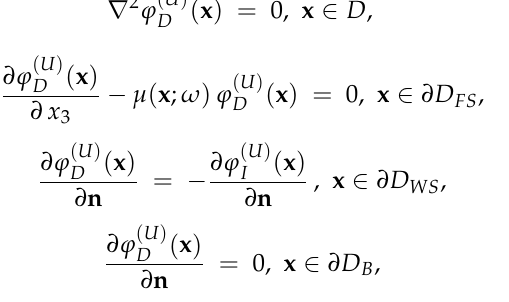
perturbation field for four cylindrical scatterers of diameter turbation field for four cylindrical scatterers of diameter D = 0.3m, h = 1m, U ∞ = ( − 0.7, 0, 0 )